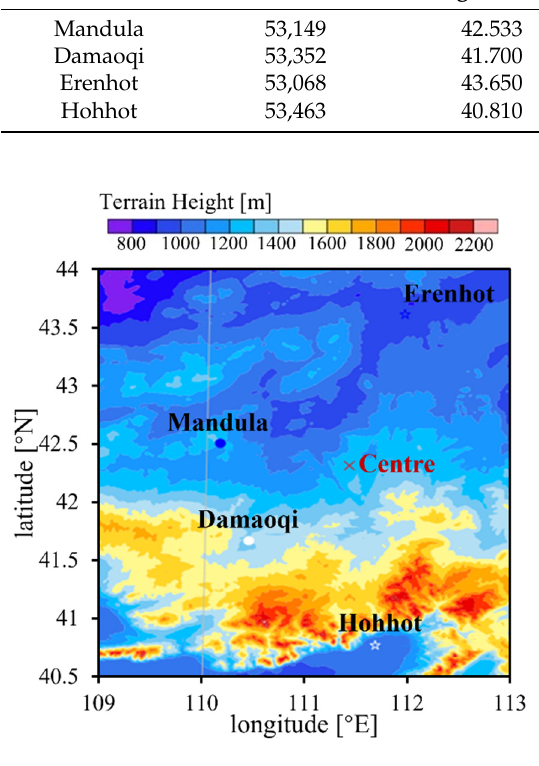
Figure 2. Terrain height map of the main landing field and its